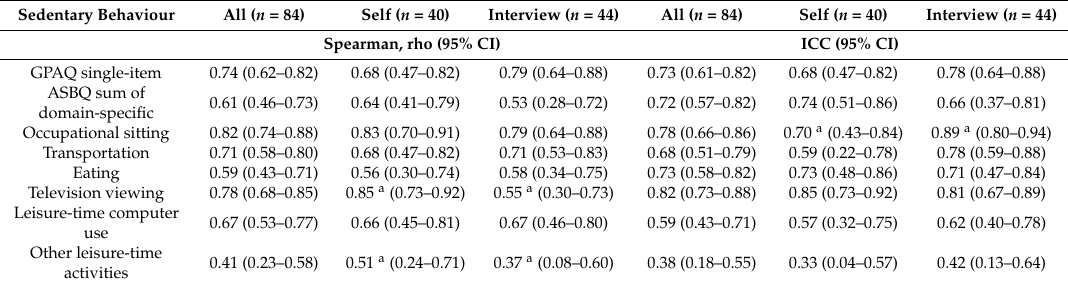
Table 2. Test-retest reliability of the Global Physical Activity Questionnaire (GPAQ) and the Adult Sedentary Behaviour Questionnaire (ASBQ) across all of the participants, self- and interviewer- administered